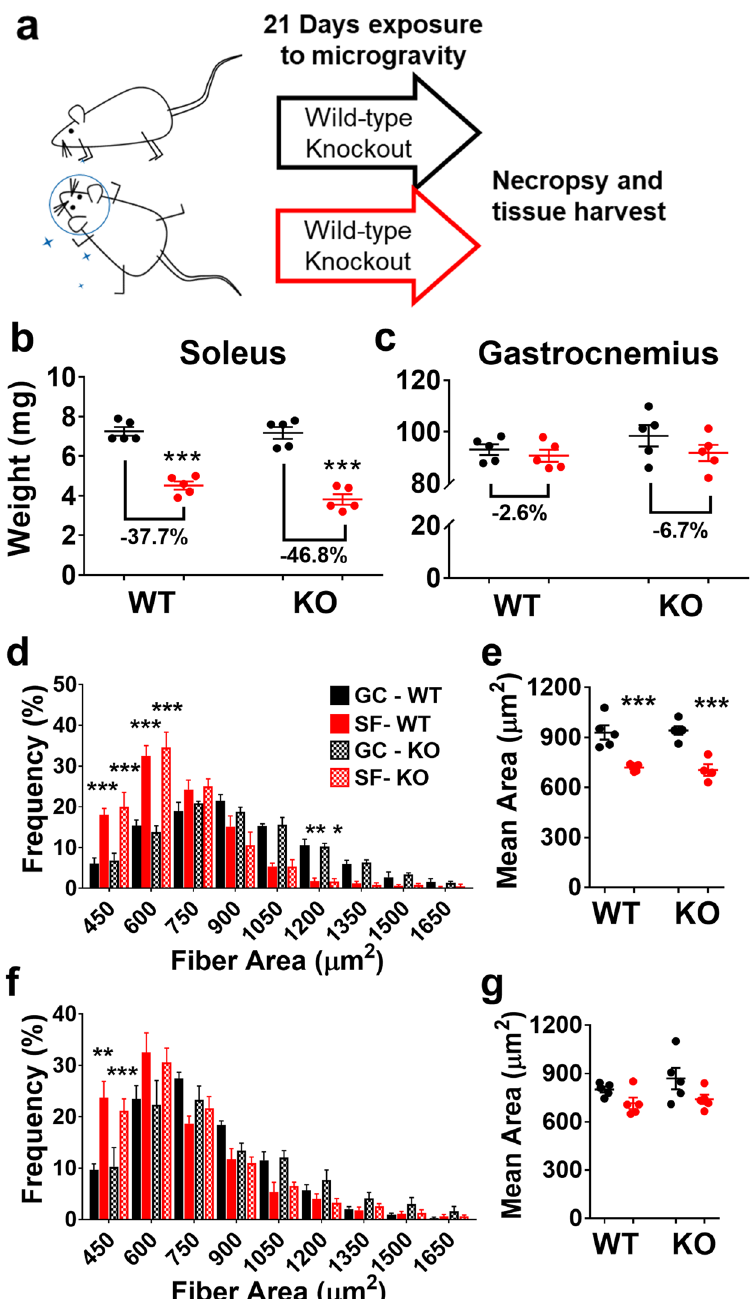
Figure 1. MuRF1 knockout does not protect against microgravity induced muscle loss. ( a ) Graphic representation of study design depicting WT and MuRF1 KO mice subjected to 21 days of Ground Control (black) or Spaceflight (red) conditions. ( b ) Both WT and MuRF1 KO mice present with significant soleus muscle loss with spaceflight. ( c ) Neither WT nor MuRF1 KO mice show significant muscle loss in the gastrocnemius muscle with spaceflight. Soleus type I fibers of both wild-type and MuRF1 KO mice show a leftward shift in fiber area frequency distribution ( d ) and a significant decline in ( e ) mean fiber area when subjected to microgravity. Type II fibers of both wild-type and MuRF1 KO mice show a moderate leftward shift in fiber area frequency distribution ( f ) but no significant difference in ( g ) mean fiber area. Data are presented as means ± SEM (n = 5/group). *** p < 0.001, Spaceflight vs. corresponding Ground Control by unpaired t-test for muscle weights. Data are presented as means ± SEM (n = 5/group). *** p < 0.001, ** p < 0.01 and * p < 0.05, Spaceflight vs. corresponding Ground Control by one and two-way ANOVA with Tukey’s and Bonferonni’s post hoc for multiple comaprisons for fiber area frequency and mean fiber area, respectively. GC, Ground Control; SF, Spaceflight; WT, Wild-type; KO,